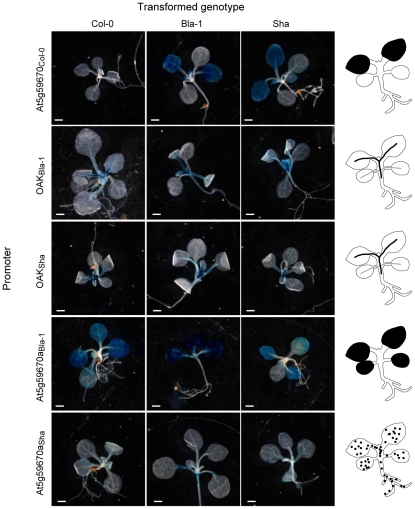
Activity domains of OAK homolog promoters.A representative T1 plant for each promoter∶GUS construct transformed into Col-0, Bla-1 and Sha is shown, with diagrams of the expression domain on the far right. Scale bar = 100 µm.